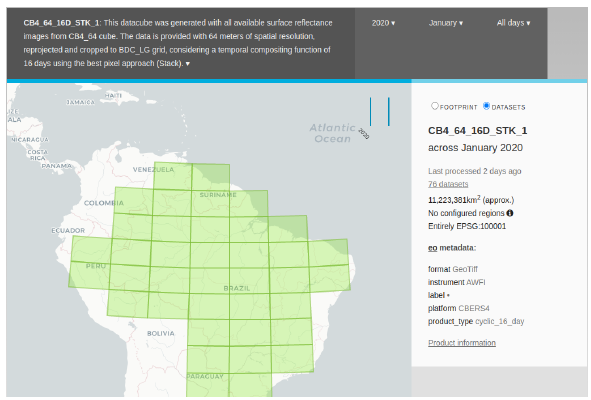
Figure 5. Explorer presenting data from the CBERS-4 collection indexed in